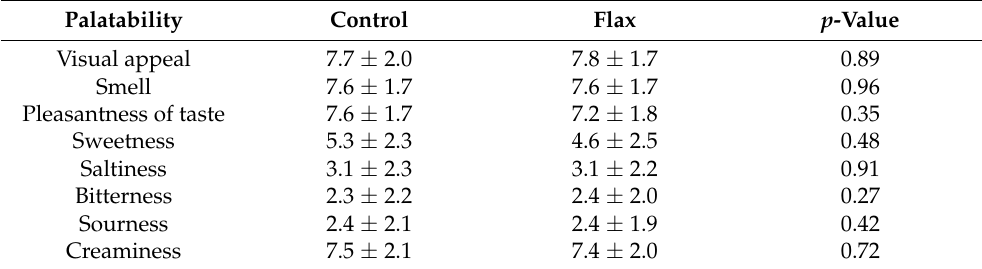
Table 2. Scores of sensory characteristics of the control breakfast and breakfast with 15 g of ground raw golden flaxseed. Data are expressed as the mean ±